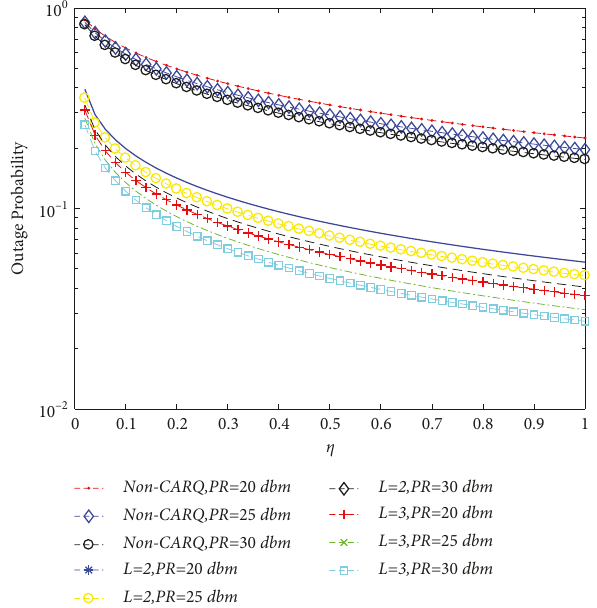
Figure 7: η vs Pr